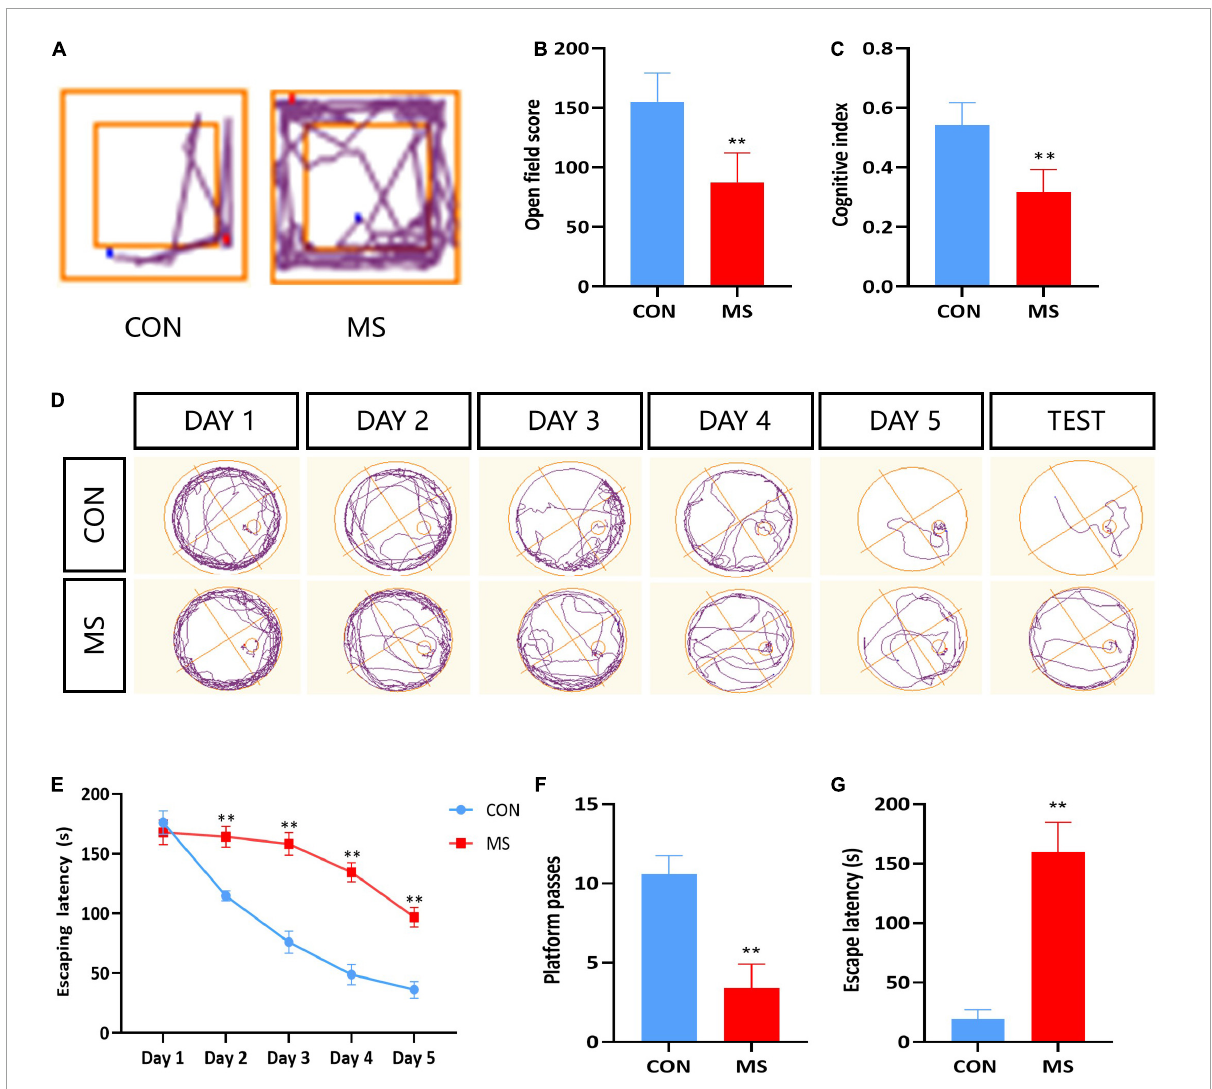
FIGURE1 MS effects on recognition dysfunction in behavior test. (A) Trajectory of open field test. (B) Open field test. (C) Novel object recognition test. (D) Trajectory of Morris water maze. (E) Escape latency of Morris water maze during learning time. (F) Platform passes of Morris water maze. (G) Escape latency of Morris water maze. ∗∗ p < 0.01 vs. control, n =